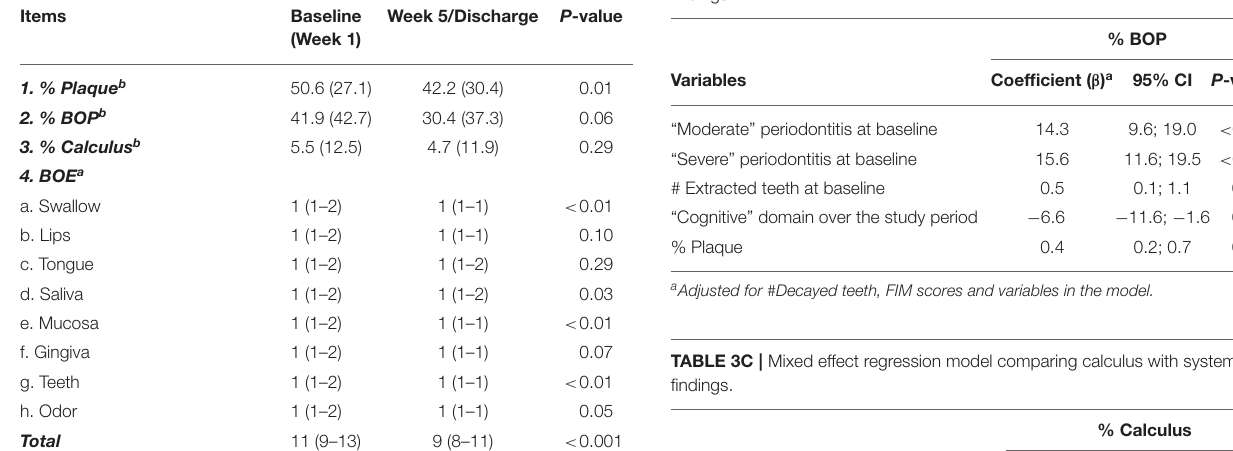
TABLE 3B | Mixed effect regression model comparing BOP with systemic findings.